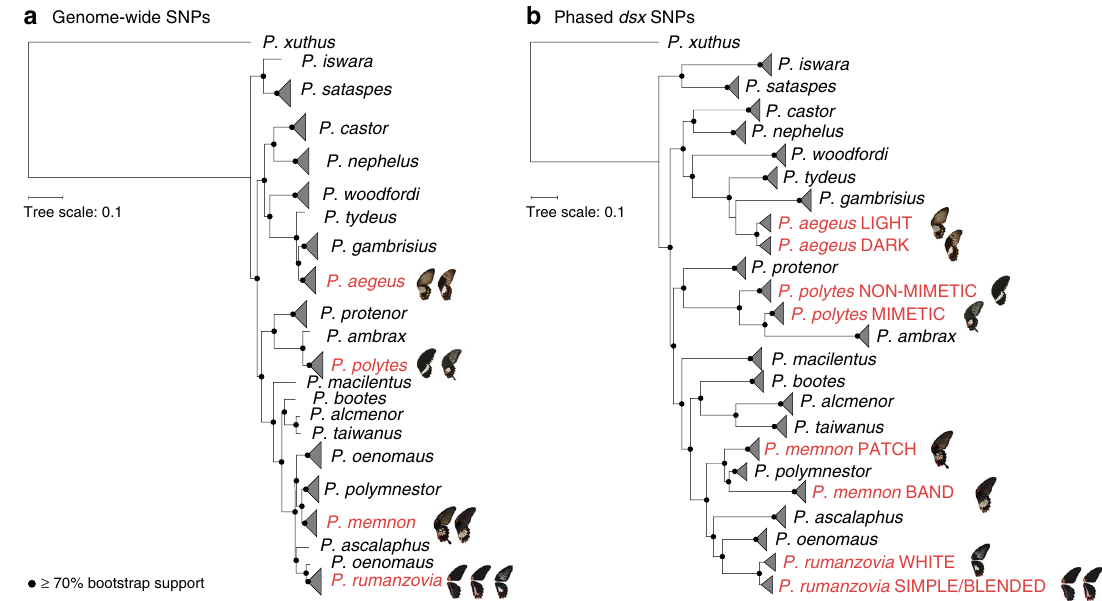
Fig. 5 Phylogenetic relationships and evolution of mimicry in Papilio . Maximum-likelihood phylogenies for polymorphic (red) and monomorphic (black) Papilio butter fl ies based on genome-wide SNPs ( a ) and phased dsx SNPs ( b